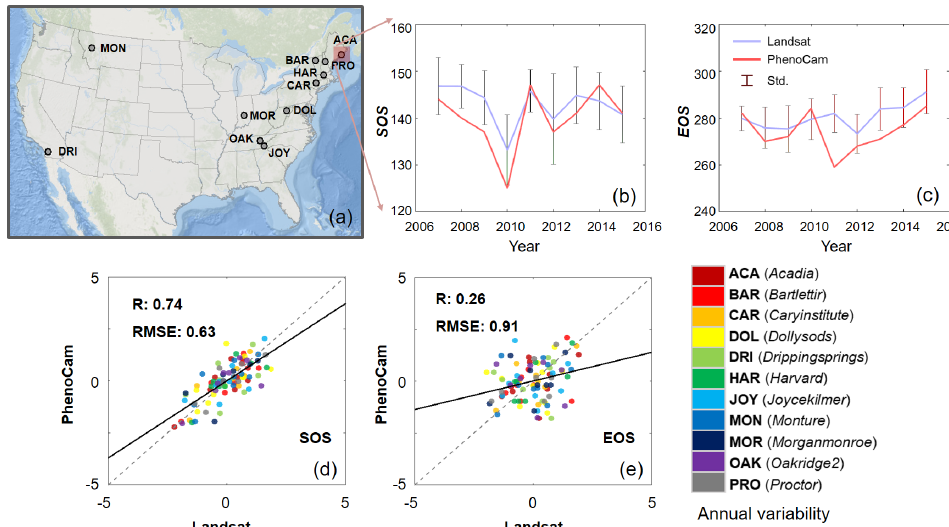
Figure 7. Selected PhenoCam sites of deciduous broadleaf forest (a) . Annual time series of phenology indicators in the station of Acadia for the start of season (SOS) (b) and the end of season (EOS) (c) . Comparison of annual variability of SOS (d) and EOS (e) between Landsat and PhenoCam phenology indicators across all stations. The annual variability for each site is defined as ( x − µ ) /σ , where x is the annual value of SOS and EOS and µ and σ are mean and standard deviation of SOS or EOS over the years.